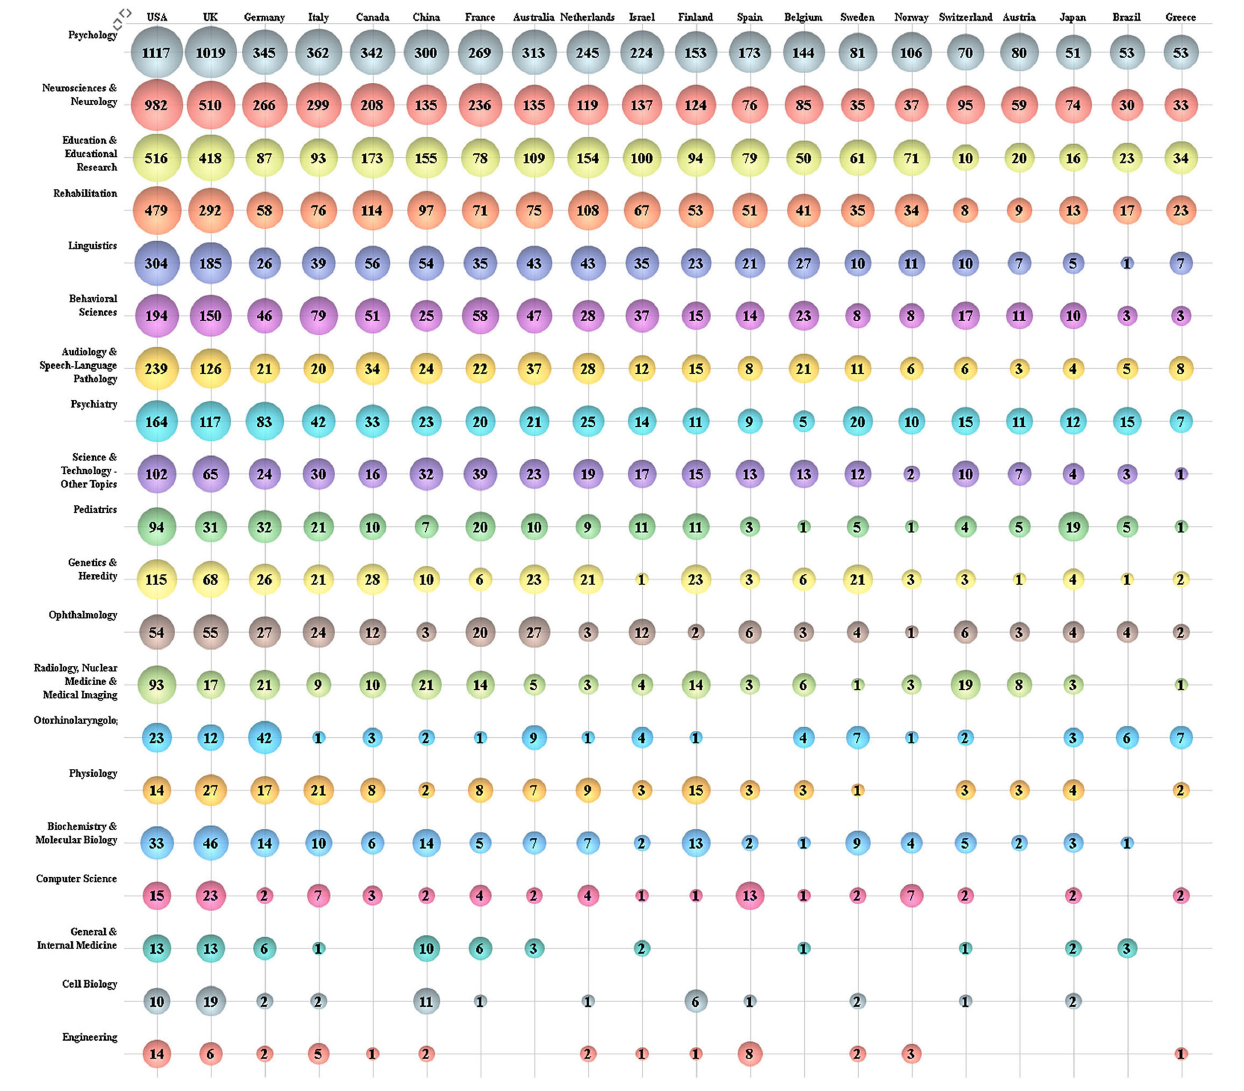
(113, 114), “rhythm” (115, 116), “bilingualism” (117, 118),